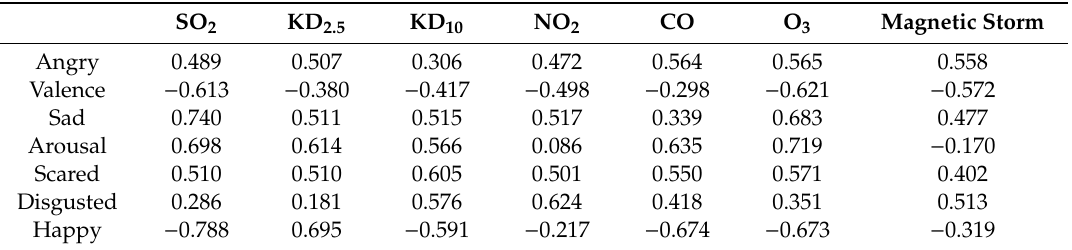
Table 8. Correlation matrix of potential housing buyers’ emotions with features characterizing the built